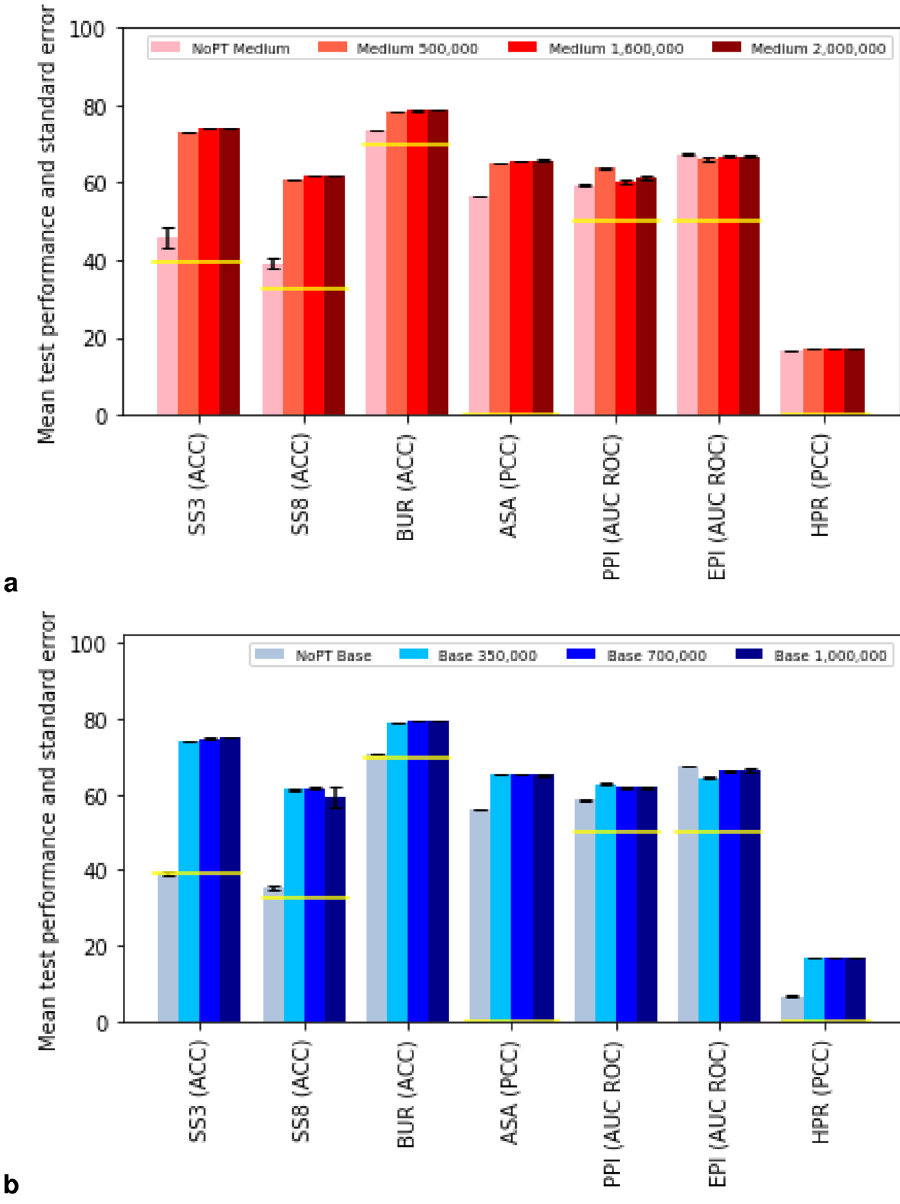
Figure 2. Performance of downstream tasks monitored during pre-training. Prediction performances of the benchmark test set, as introduced in section ProteinGLUE Benchmark tasks , ( a ) for a medium sized model, and ( b ) for a base sized model, trained without the pre-training step (pink/grey), and on a pre-trained model for 350 000 (light red/blue), 700 000 (red/blue) and 1 000 000 steps (dark red/blue). Further details as in Fig.